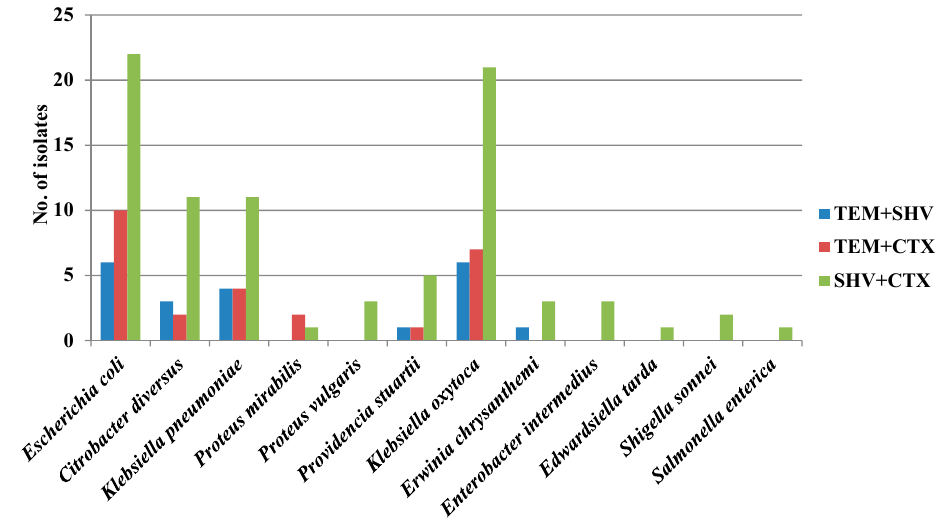
Figure 1. Co-occurrence of two ESBL genes in antibiotic-resistant isolates.